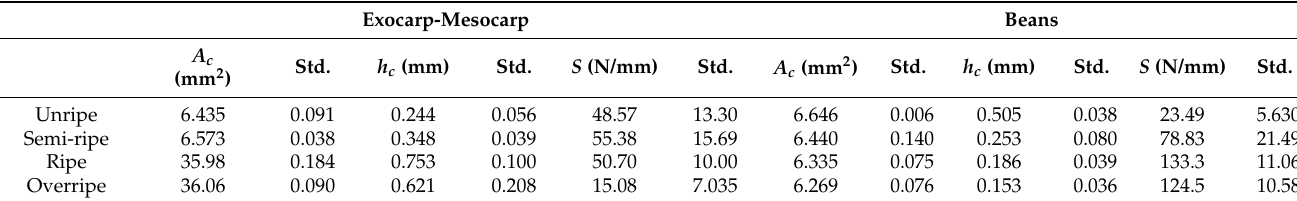
Table 3. Parameters for calculation of elastic properties of Coffea arabica L. var. Castillo fruit and bean. Exocarp-Mesocarp